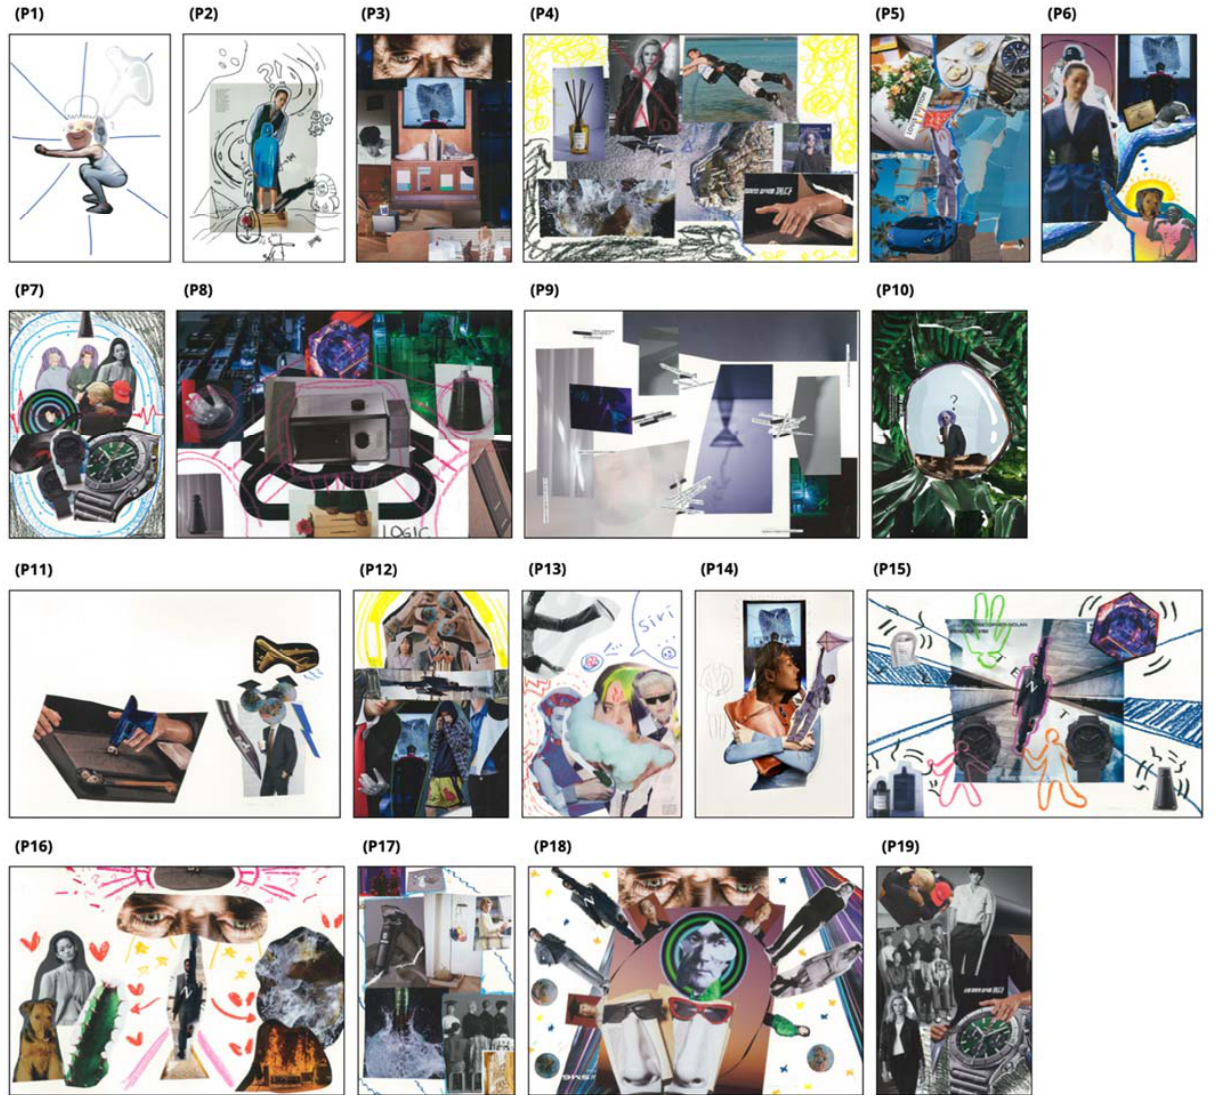
Figure 5. Collage Image of all participants. Table 3. Examples of Collage Image Analysis.